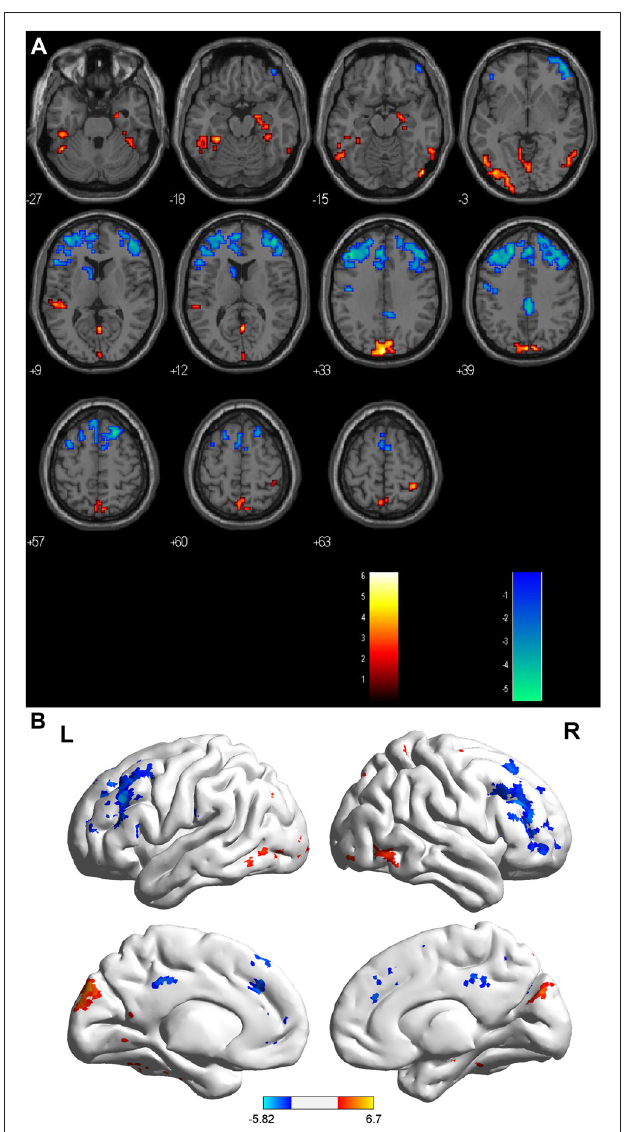
FIGURE 1 | (A,B) ALFF: RED = NC > sON; BLUE = sON > NC. Brain areas showing significant ALFF differences between the single optic neuritis (sON) patients and normal controls. Notes: the different brain regions include the bilateral cuneus/precuneus, bilateral fusiform gyrus, bilateral inferior occipital gyrus, right posterior cingulate, right parahippocampal gyrus/hippocampus, right postcentral gyrus and left superior temporal gyrus, left middle frontal gyrus, right superior frontal gyrus, right middle cingulate gyrus, left medial frontal gyrus, left precentral gyrus and left caudate. The red areas represent lower ALFF brain regions, and the blue areas represent higher ALFF brain regions (corrected p < 0.01 using AlphaSim). Abbreviations: ON, optic neuritis; ALFF, amplitude of low-frequency fluctuation; L, left; R, right. gyrus and left caudate. The rON patients showed increased ALFFs in the bilateral inferior gyrus and left medial frontal gyrus. Previous publications revealed that visual cortical areas that selectively process relevant information are functionally connected with the frontal-parietal network, whereas those that process irrelevant information are simultaneously coupled